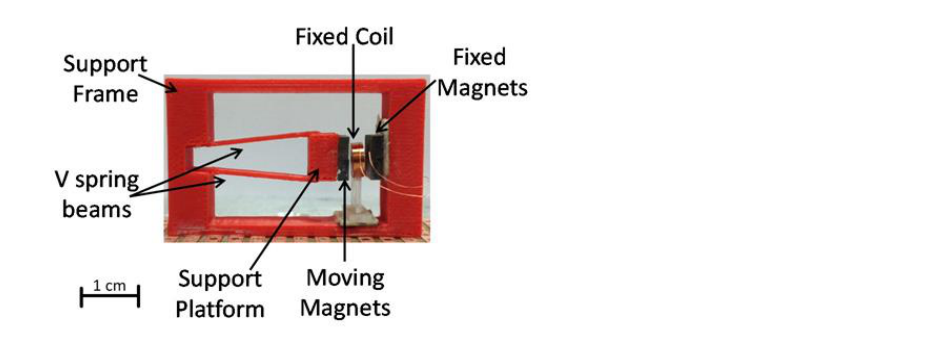
Figure 4. The 3D printed harvester created by [52]. A V-shaped spring is used to vibrate a magnet on one side, while the other uses a fixed magnet.